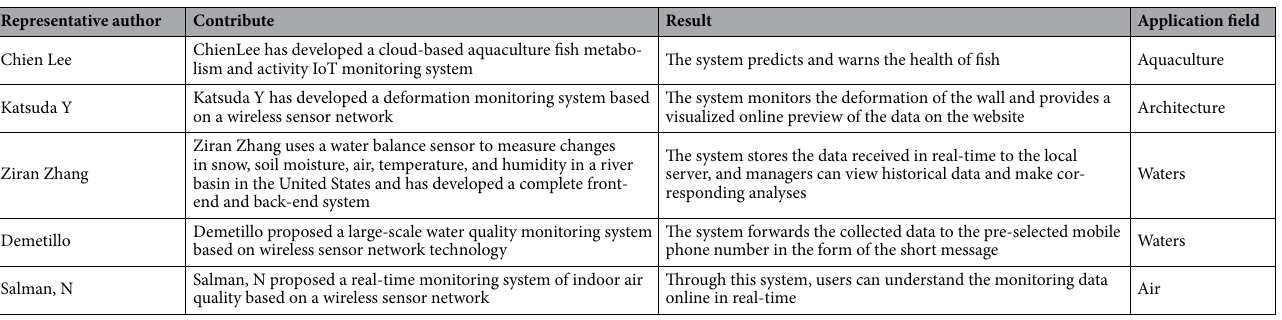
Table 1. The comparison of advanced